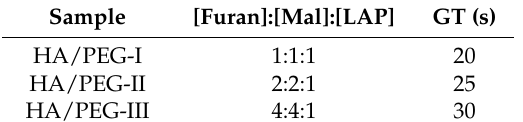
Table 1. The gelation time (GT) of HA/PEG hydrogel.